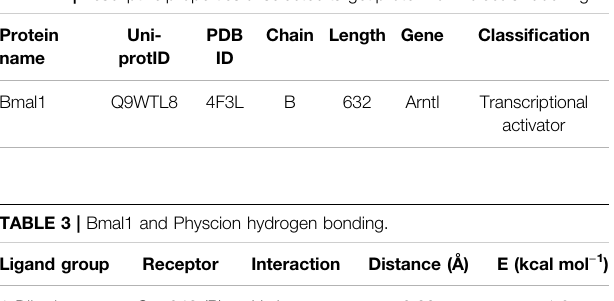
TABLE 2 | Descriptive properties of selected target protein for molecular docking.